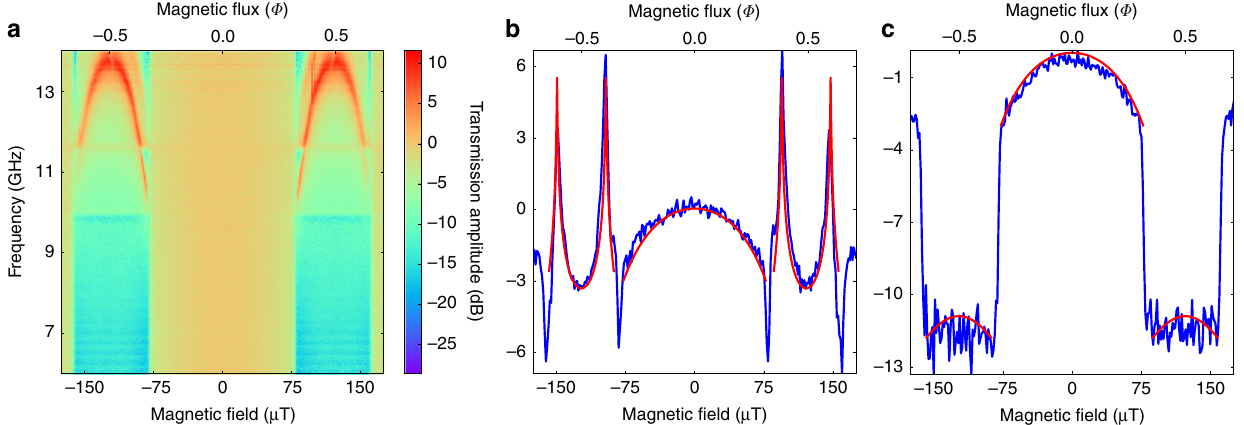
Fig. 3 Transmission of microwaves through the quantum metamaterial in different regimes. a The measured dependence of the amplitude of transmission coef fi cient t (normalized to the value at zero fi eld) on applied dc magnetic fi eld (proportional to the bias current in the coil, lower axis) and frequency f . The upper horizontal axis translates the fi eld in magnetic fl ux Φ per qubit single loop. The transmission t displays the sharp changes under variation of the magnetic fl ux Φ . One can see two different ranges of microwave propagation, nearly fl at transmission around zero fi eld and sharp resonant enhancement of the transmission near 11 – 14GHz at magnetic fl ux Φ ~ ± Φ 0 /2. b A cross-cut of a at the fi xed frequency of 13GHz. The sharp peaks correspond to coherent tunneling between quantum states in the twin qubits (see text). c A cross-cut of a at the fi xed frequency of 10GHz. The sharp jumps correspond to a transition between zero and π phase on the central junction of the twin qubit (see text). Red curve is a fi t to the theoretically predicted dependence Eq.